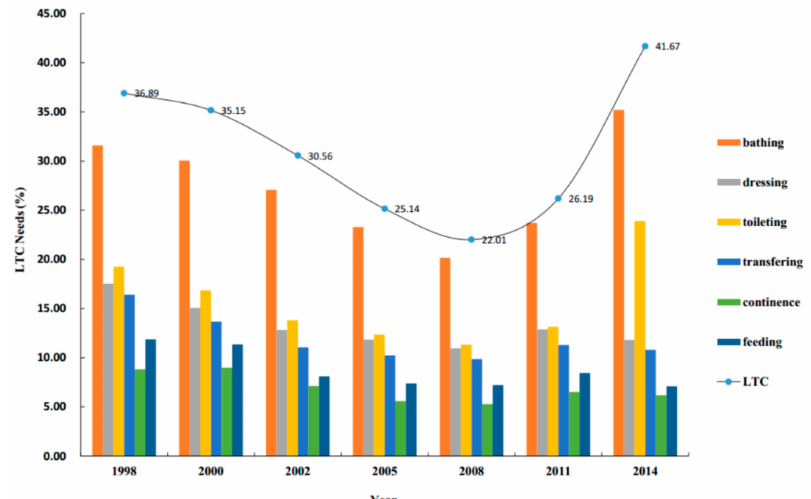
Figure 1. The status of LTC needs of the elderly from 1998 to 2014. Notes: LTC services needs including bathing, dressing, toileting, indoor transferring, continence and eating in this study. As long as any of the six daily living abilities of the elderly cannot be done and are indicated as needing need help, it means that the elderly have LTC